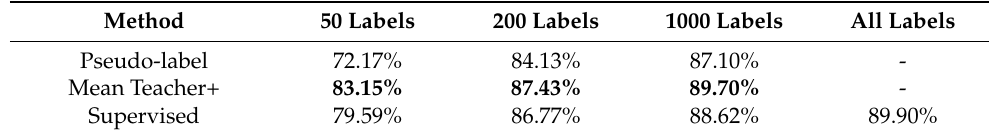
Table 4. Accuracy of various algorithms under different label samples.